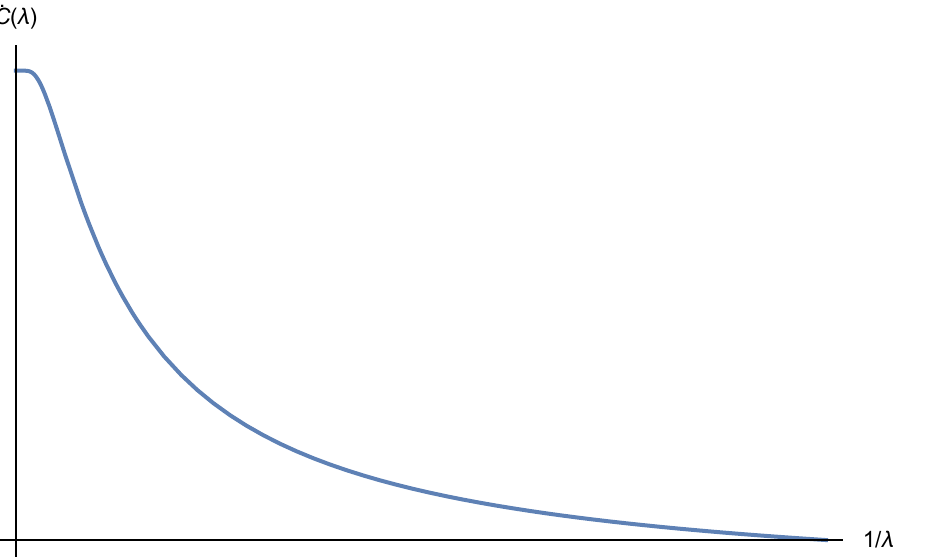
Figure 14. A possible graph of _ C ( (cid:21) ). We have chosen this function to demonstrate visually the possible e(cid:11)ects of _ C ( (cid:21) ) not being analytic at (cid:21) = 1 , but do not claim that it should be interpreted as a precise prediction for the form of _ C ( (cid:21)